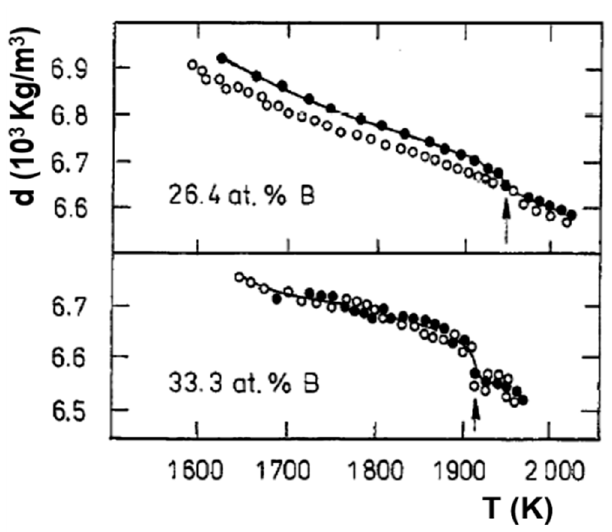
Figure 15. Temperature dependence of the density d of Fe-26.4 at %B and Fe-33.3 at %B melts at heating after melting ( • ) and subsequent cooling (o). Arrow shows the anomaly linked with structural transformation in a liquid compound. Reprinted with permission from ref. [24], Figure 8, Copyright 1997 Elsevier.